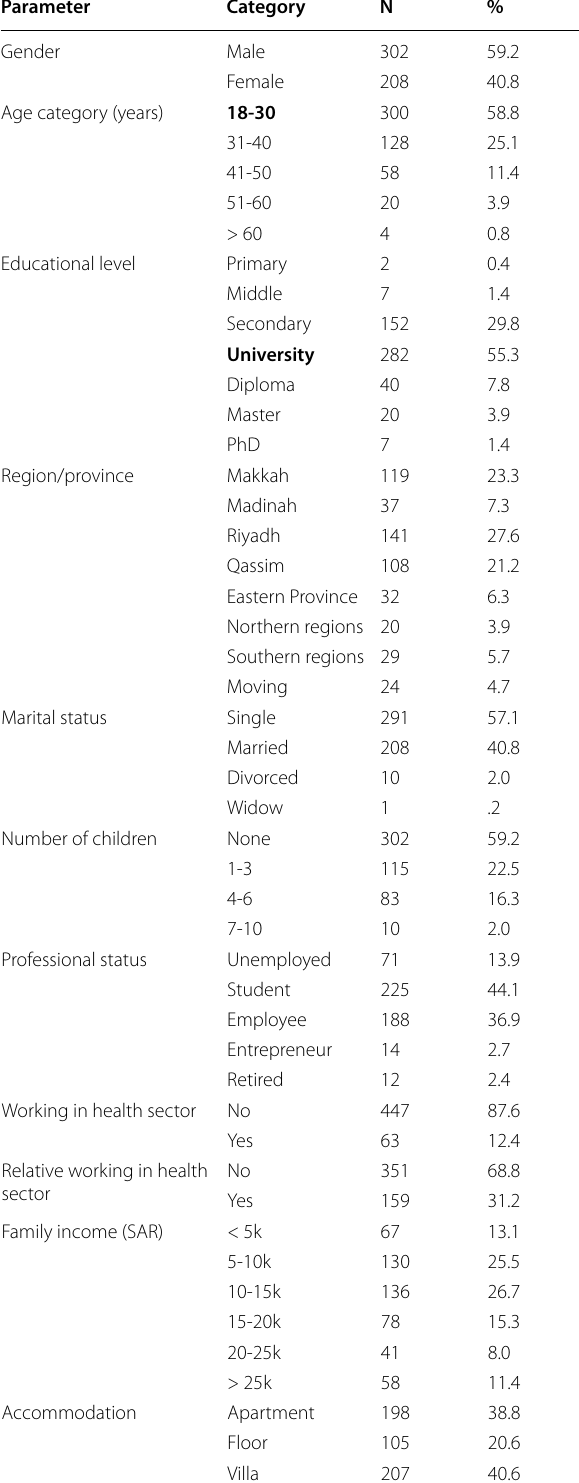
Table 1 Participants’ characteristics ( N